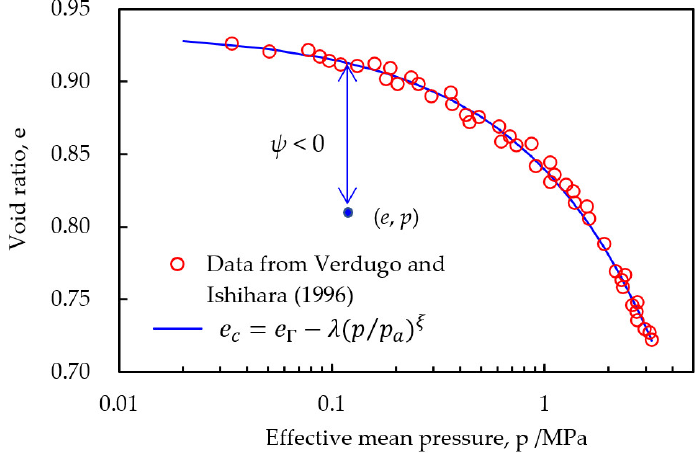
Figure 2. Critical state line and state parameter.